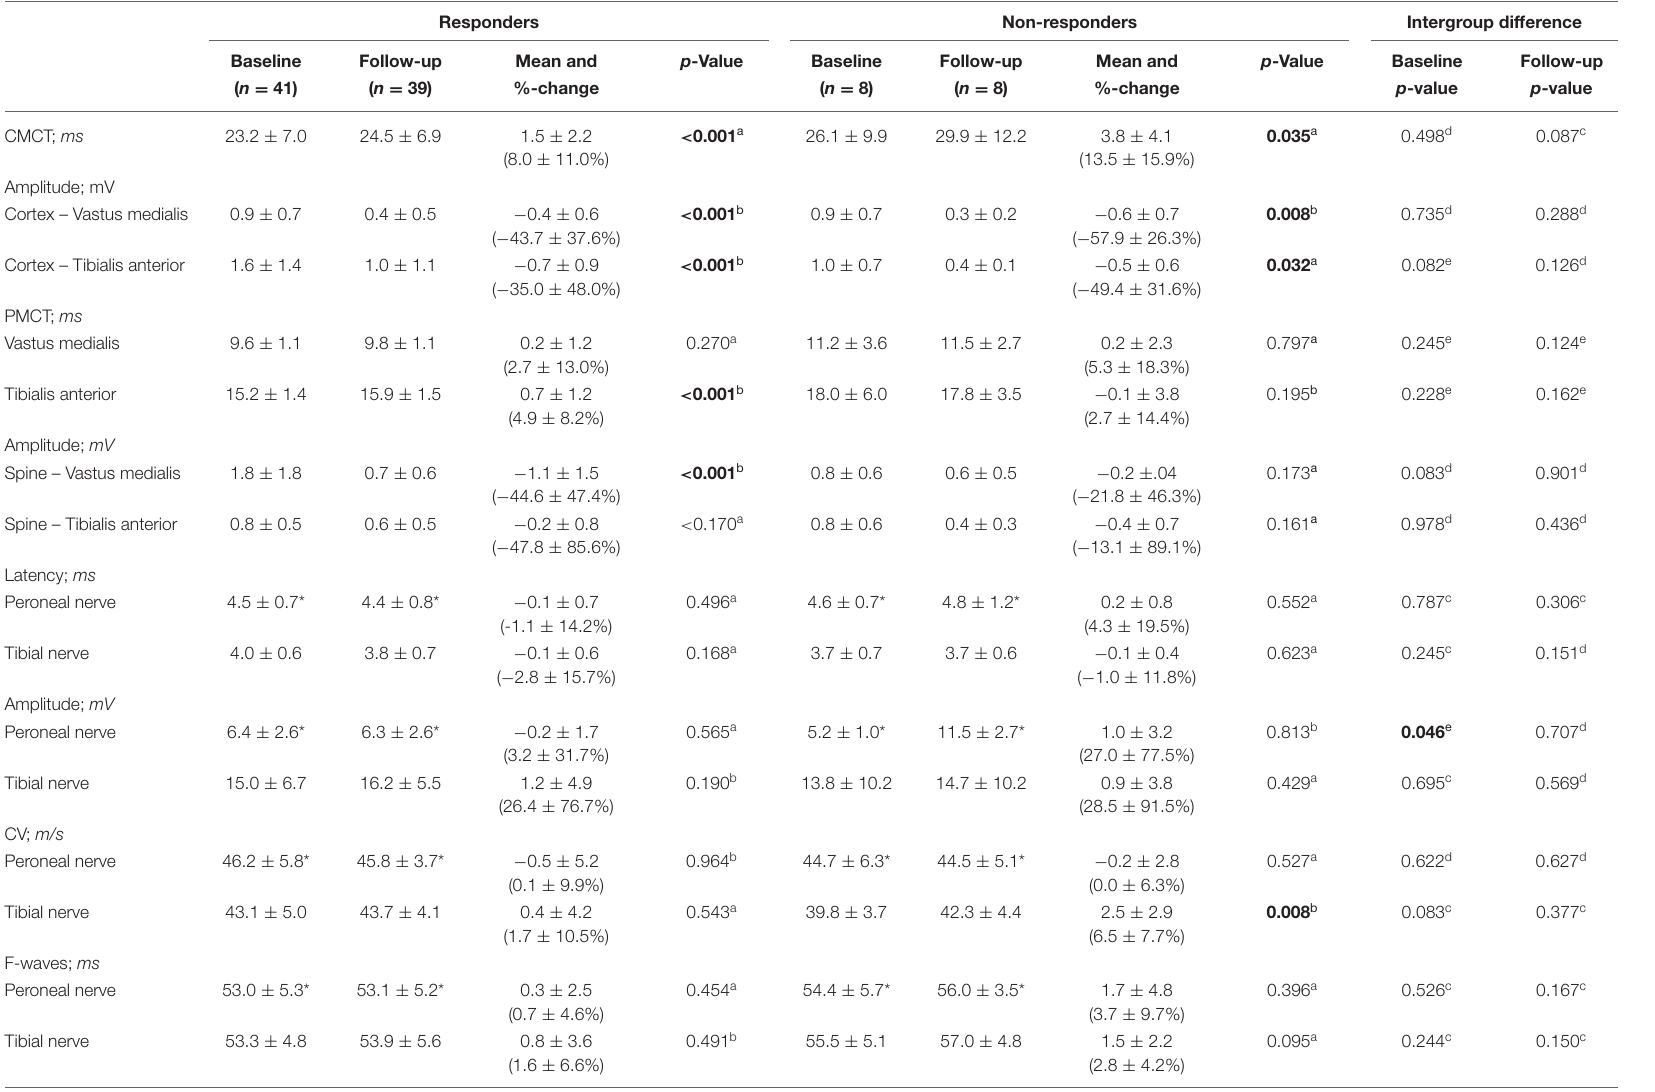
TABLE 2 | Neurophysiological examinations at baseline and 1 year in responders and non-responders to Fampridine